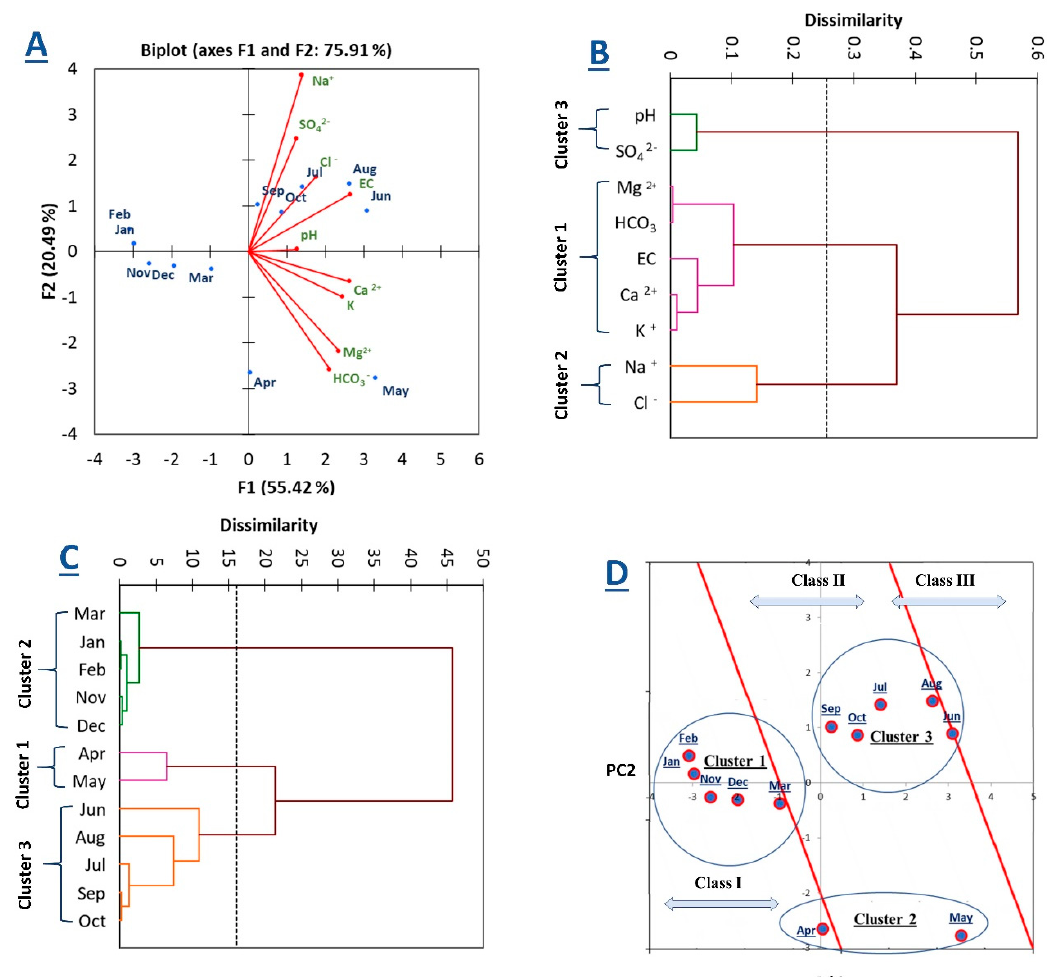
Figure 8. Classification of water quality based on the principal component analysis (PCA) and agglomerative hierarchical clustering (AHC) techniques. ( A ) The relationships between water chemical parameters, ( B ) a dendrogram for clustering chemical properties, ( C ) a dendrogram for clustering monthly variation, and ( D ) the final classification of water quality.